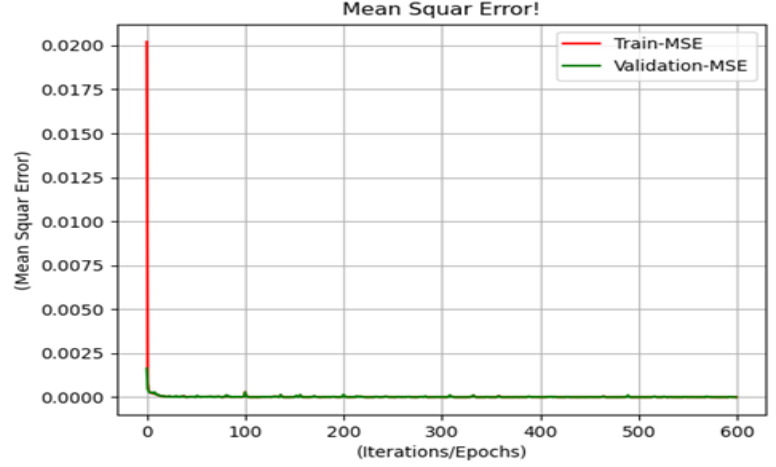
Figure 21. Mean Square Error After ANN Training.